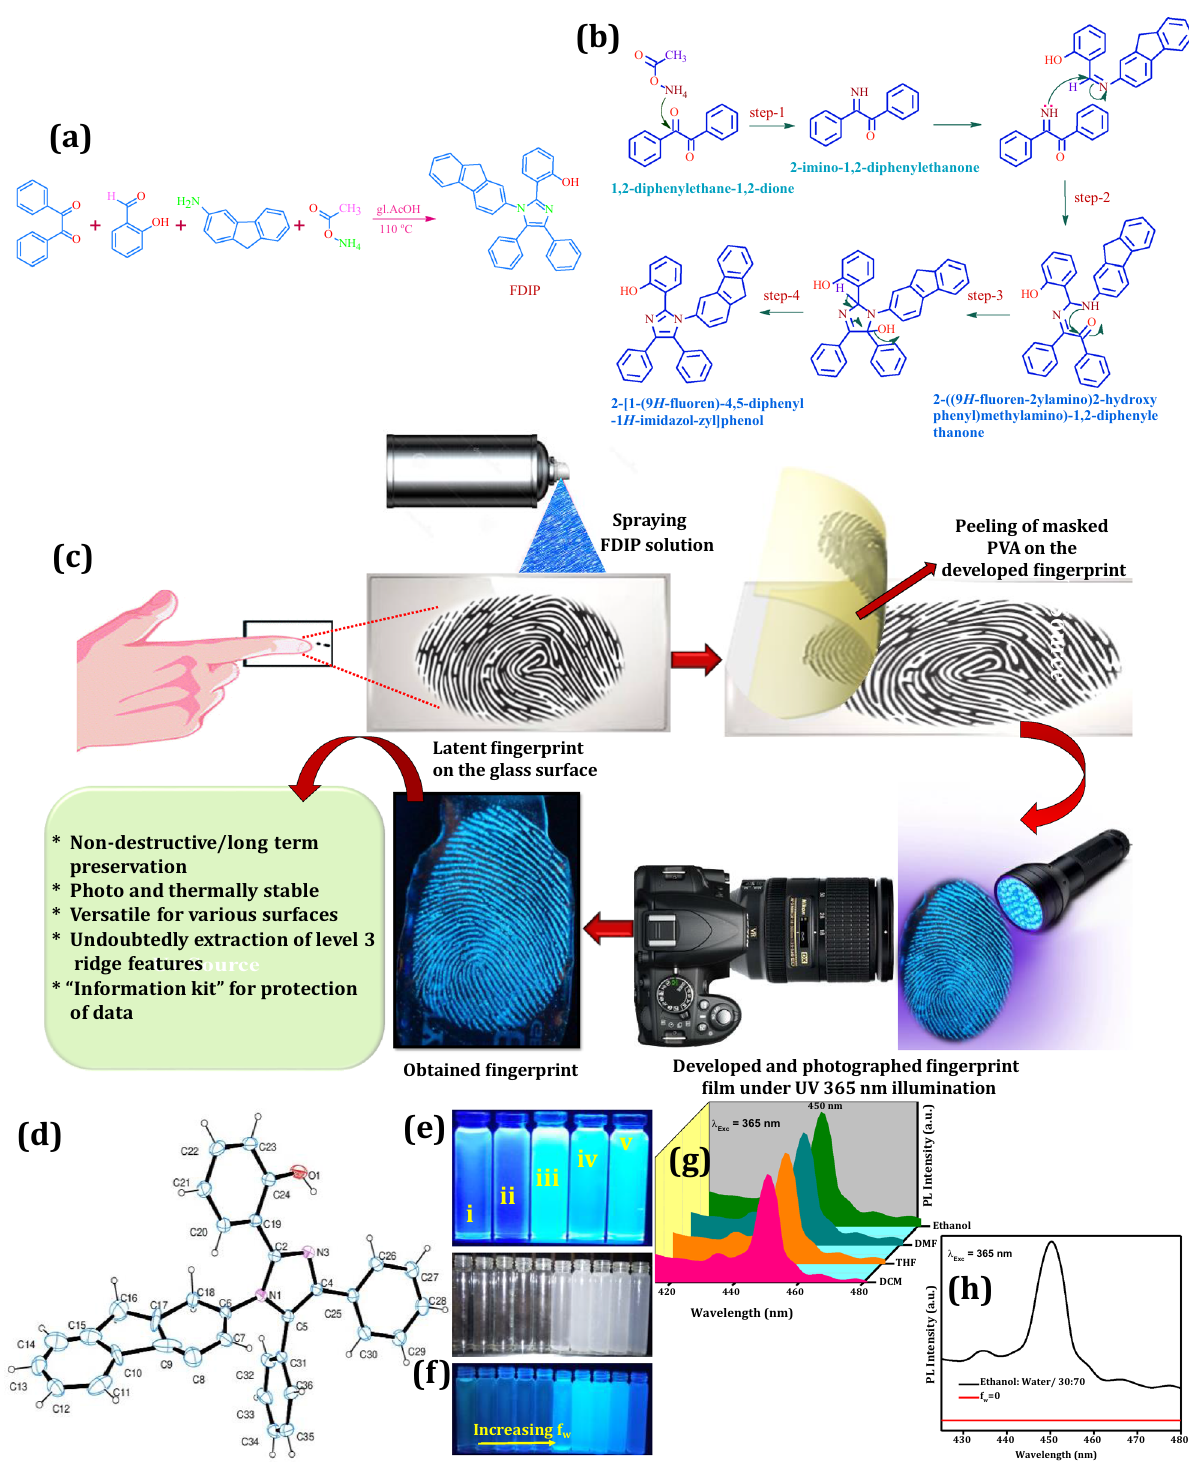
Figure 1. Schematic illustration for the ( a ) synthesis of FDIP molecule; ( b ) step by step chemical reaction involved in synthesis of FDIP molecule; ( c ) development and visualization of long term preservative FPs using optimized FDIP molecule by spraying method followed by PVA wrapping; ( d ) ORTEP diagram of FDIP molecule. Color code: N-violet, O-red, C-blue; ( e ) photographic images of FDIP molecule under UV 365 nm light in various solvents (i) DCM, (ii) DMF, (iii) ethanol and (iv) THF; ( f ) AIE images of the FDIP molecule with various fw values in ethanol under normal and 365 nm light; ( g ) PL spectra of FDIP molecule in various solvents excited at 365 nm light; ( h ) PL spectra of FDIP molecule with fw = 0 and